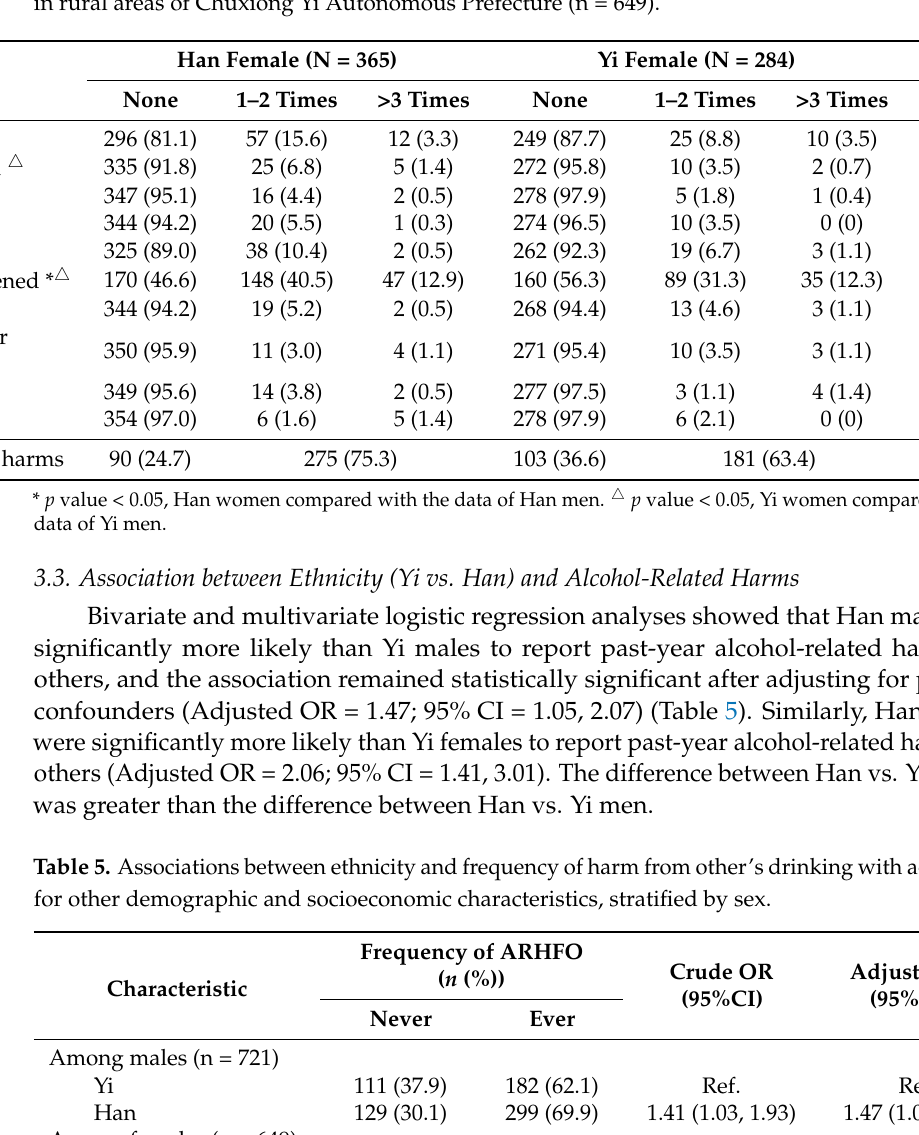
Table 4. Frequency of harm from other’s drinking in the past 12 months among Han and Yi females in rural areas of Chuxiong Yi Autonomous Prefecture (n = 649).